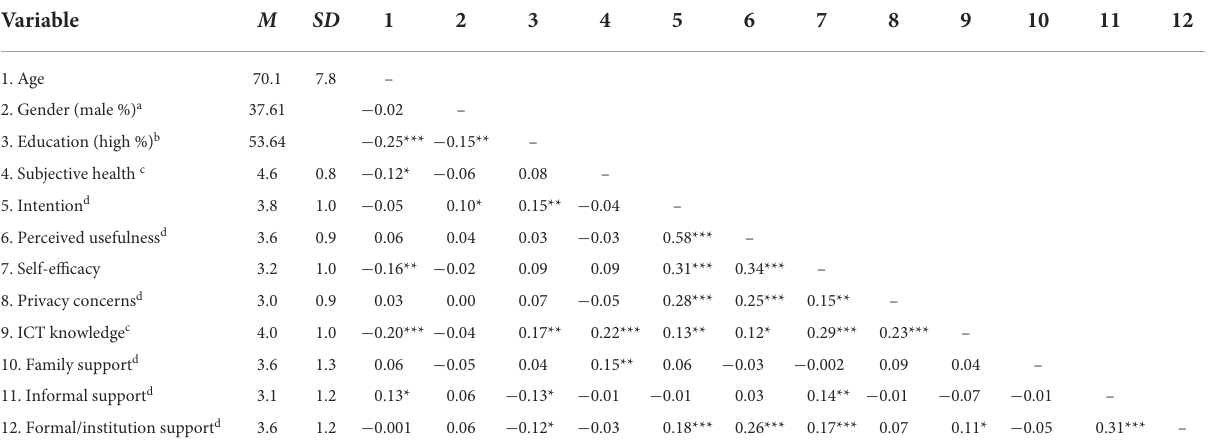
TABLE 1 Descriptive statistics and correlations for study variables.